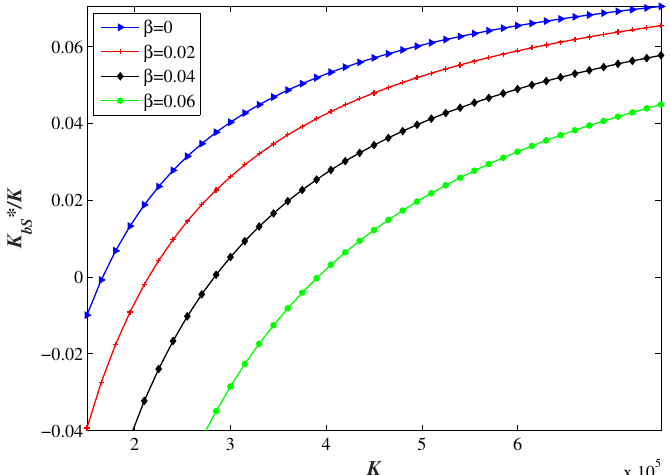
Figure 7. Optimal security investment allocation under security information sharing with budget